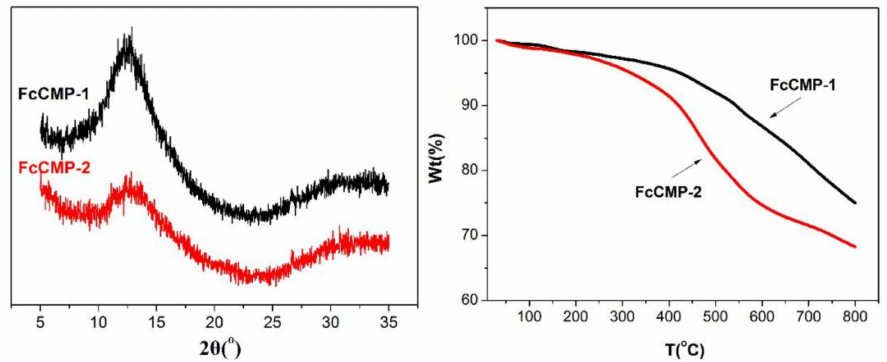
Figure 3. XRD (left) patterns and thermogravimetric analysis (TGA) curves (right) of FcCMP-1 and FcCMP-2.